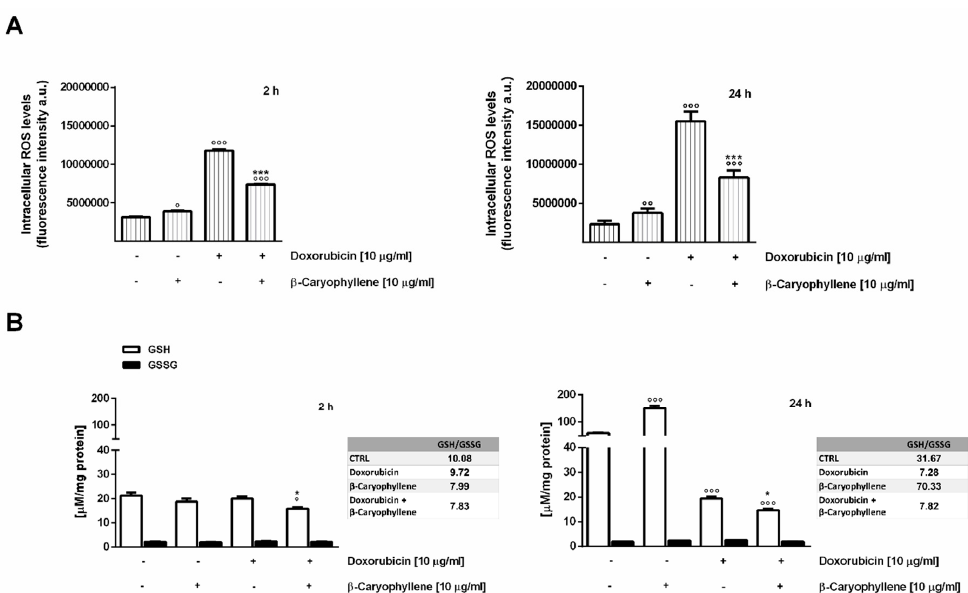
Figure 8. Effect of the natural sesquiterpene β -caryophyllene (50 µM), doxorubicin (20 µM) and their combination compared the control on the intracellular oxidative stress in Mz-ChA-1 cholangiocarcinoma cells. The cells were treated for 2 h and 24 h, then the pellets were harvested for the subsequent analysis. ( A ) Bar graphs representing the levels of reactive oxygen species (ROS) as detected by the 2,7-dichlorofluorescein diacetate (DCFH-DA) assay. Data are expressed as mean ± standard error of at least two independent replicates. ( B ) Bar graphs representing the levels of GSH (reduced glutathione) and GSSG (oxidized glutathione) as revealed by HPLC analysis. Data are expressed as mean ± standard error of at least two independent replicates. ° p < 0.05, °° p < 0.01 and °°° p < 0.001 (one-way ANOVA followed by Dunnett’s multiple comparison post-test) denote a significant difference of the treatments compared the control. * p < 0.05 and *** p < 0.001 (t-Student test) denote a significant difference with respect to doxorubicin.